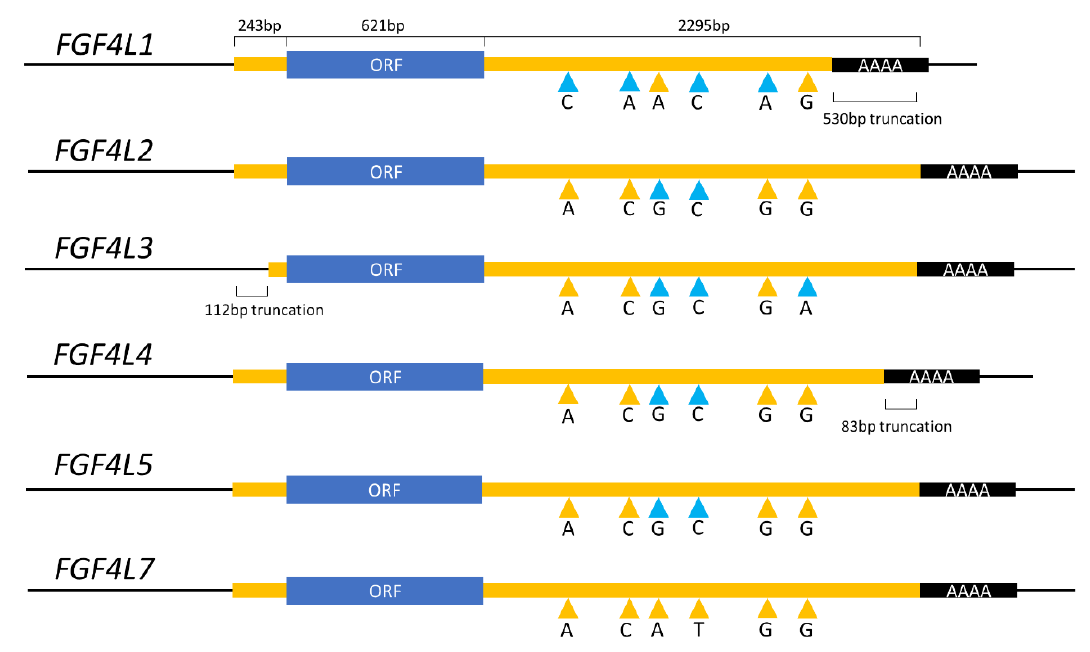
Figure 1. Comparison of the six full length FGF4 retrocopies identified in domestic dogs. From left to right, the letters with colored arrowheads represent variants within the 3′ UTR of the FGF4 gene at